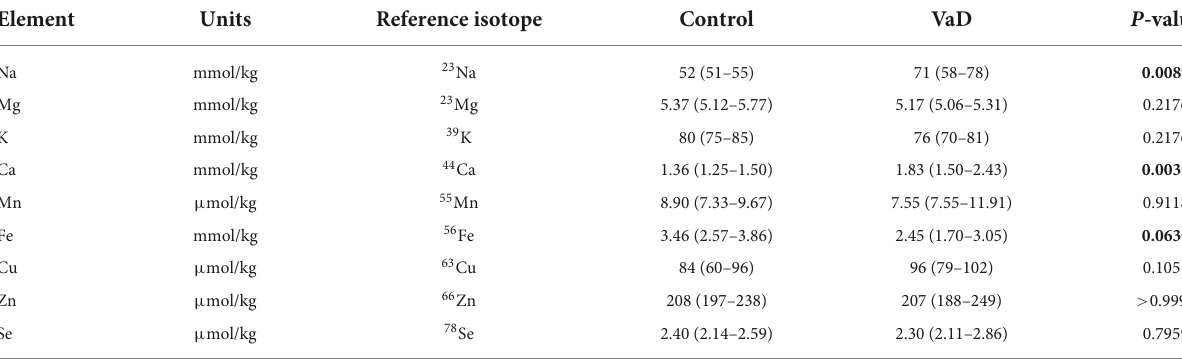
TABLE 6 Wet-weight metal concentrations in the basal ganglia of VaD and control brains.